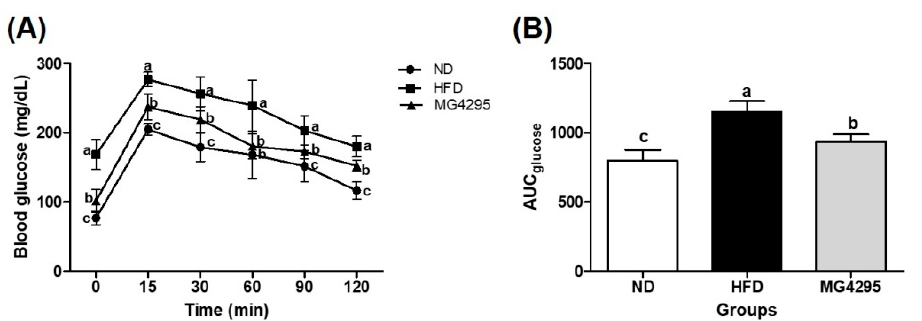
Figure 2. Effect of L. fermentum MG4295 on ( A ) OGTT and ( B ) AUC in HFD-induced mice. The results are presented as mean ± SD ( n = 8). Different letters indicate a significant difference at p < 0.05.